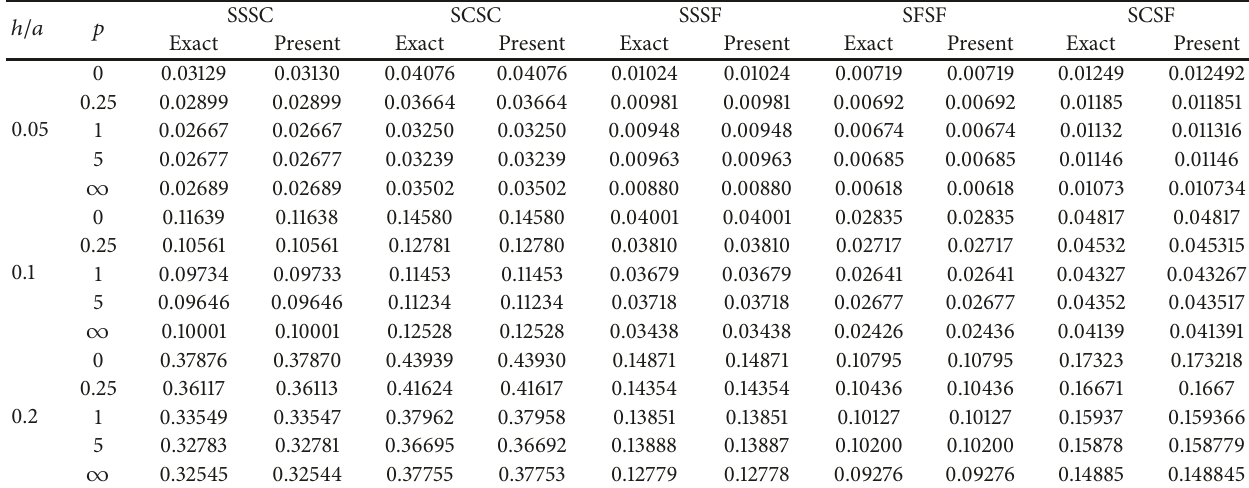
Table 10: Comparison of fundamental frequency parameter Ω = 𝜔ℎ(𝜌 𝑐 /𝐸 𝑐 ) 1/2 for Al/ZrO 2 plates when 𝑎/𝑏 = 1.5 .